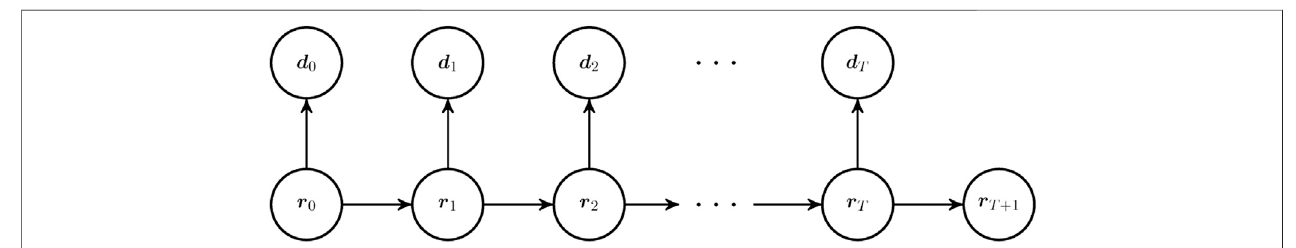
FIGURE 4 | Graph of the hidden Markov